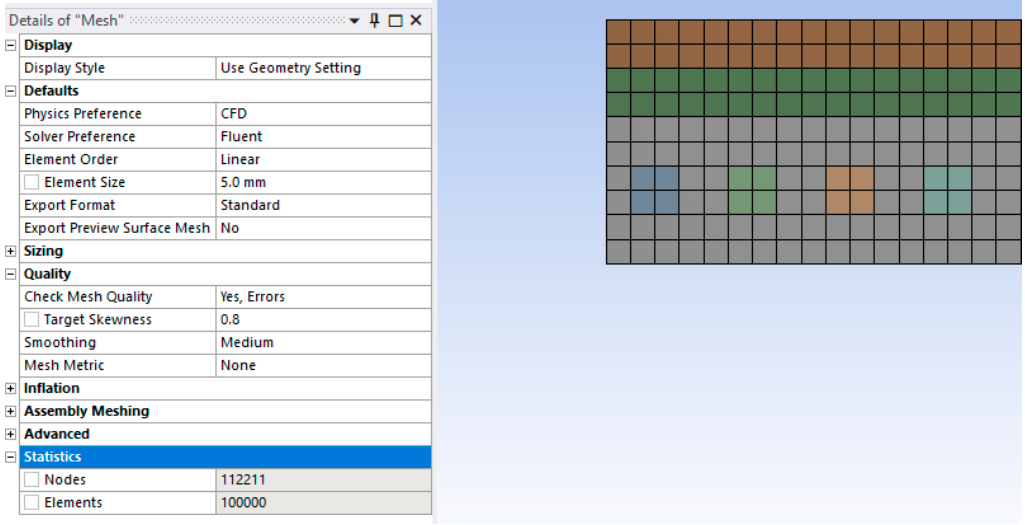
Figure 4. Model mesh sizing and initialization.